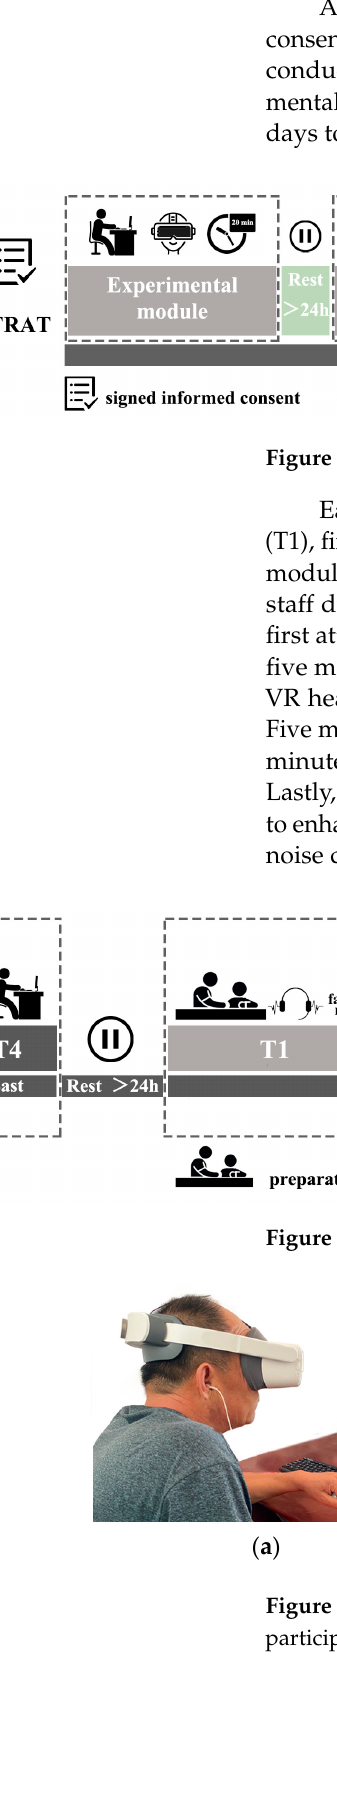
Figure 4. The visual recovery and attention task experiments site.